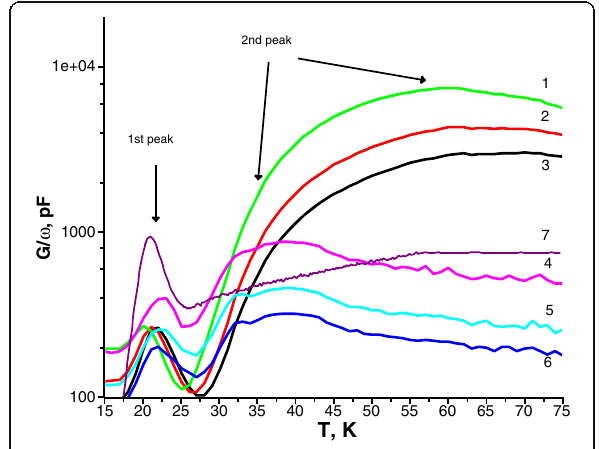
Fig. 5 Temperature spectra of conductance of type 3 sample, measured at the voltages of +1 V ( 1 – 3 ) and +2 V ( 4 – 6 ) at various frequencies 1 1 kHz, 2 2 kHz, 3 3 kHz, 4 1 kHz, 5 2 kHz, 6 3 kHz. 7 Temperature spectra of conductance of type 1 sample, measured at the applied bias voltage of +2 V and frequency of the test signal of 500